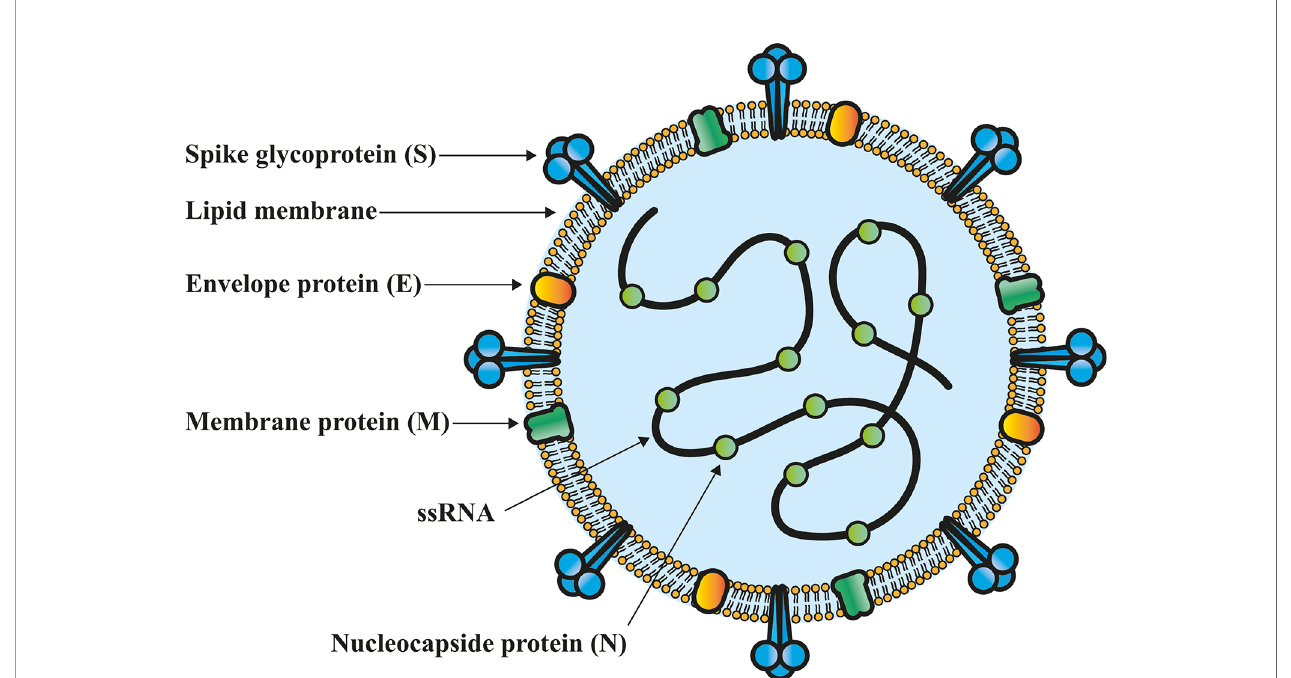
FIGURE 1 | Structural characteristics of SARS-CoV-2 virion. Nucleocapsid (N) protein is associated to the single-stranded genomic RNA (ssRNA), which is covered by an outer envelope of the main structural proteins: S glycoprotein (S), membrane protein (M) and envelope protein (E), which are found in the lipid membrane of the